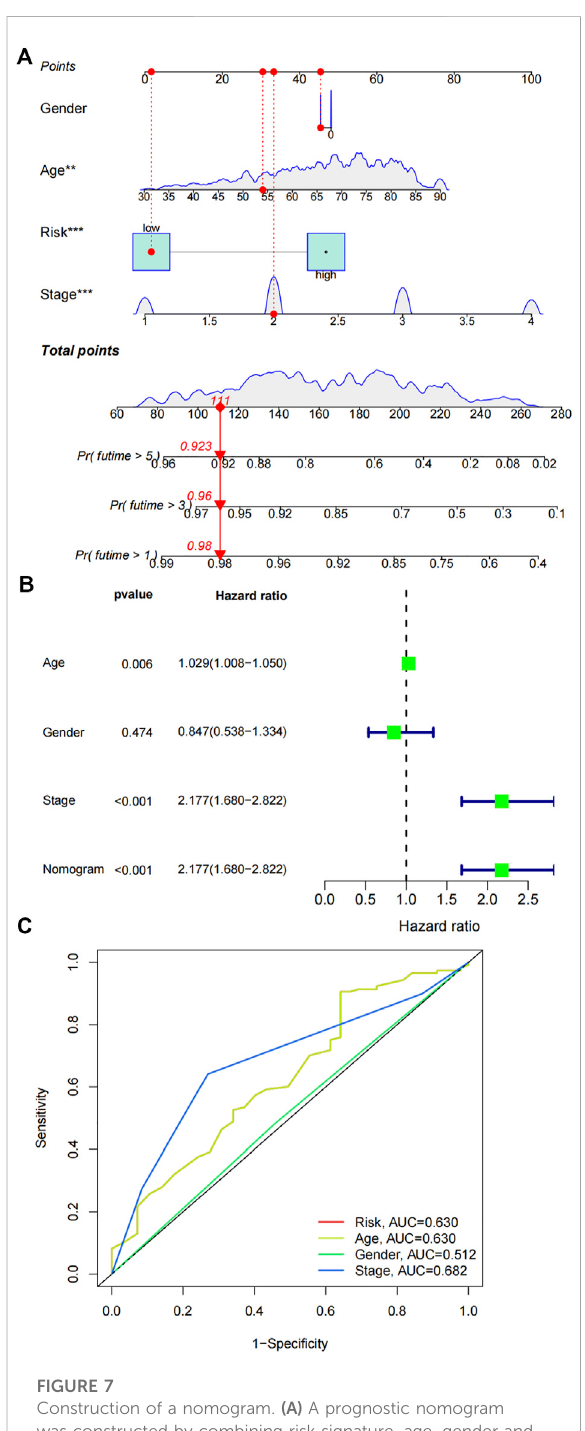
FIGURE 7 Construction of a nomogram. (A) A prognostic